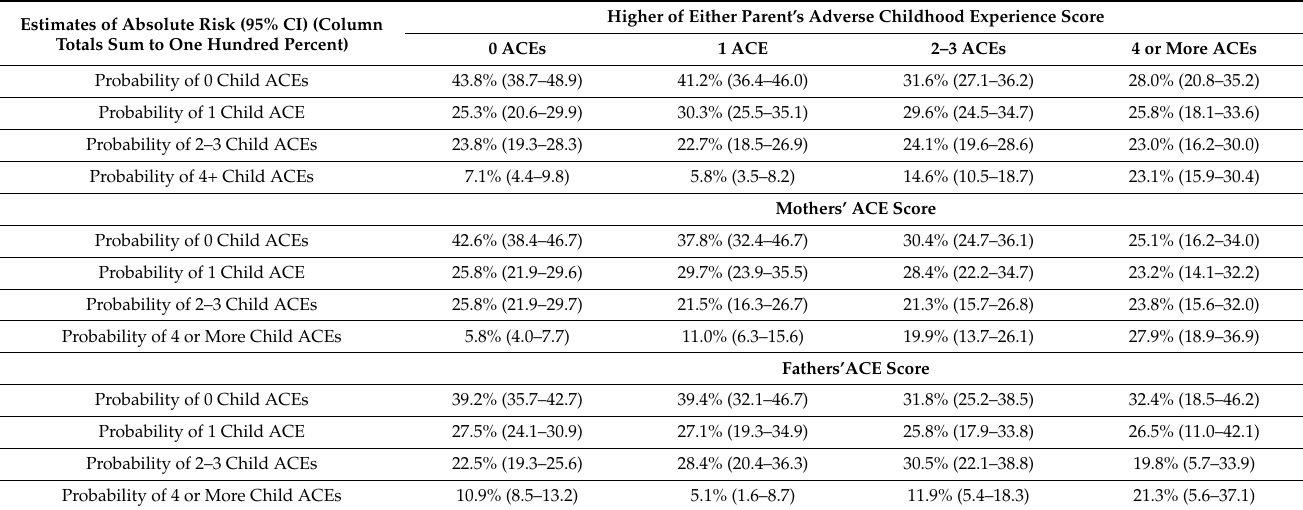
Table 3. Absolute Risk of Child ACE Count Category by Highest of Either Parent’s ACE Count Category. Estimates of Absolute Risk (95% CI) (Column Totals Sum to One Hundred